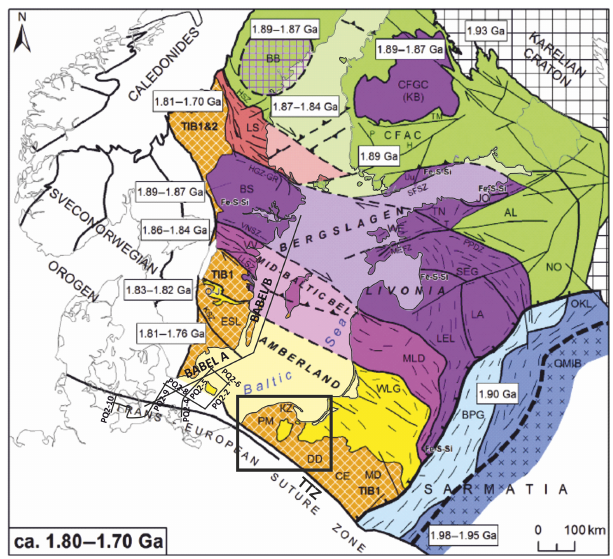
Figure 1. Major Paleoproterozoic tectonic domains of Fennoscan- dia across the Baltic Sea area. The black rectangle shows the study area. The location of the BABEL A–B (BABEL Working Group, 1993) and DEKORP-PQ (Meissner and Krawczyk, 1999) deep re- flection profiles is also marked. The known extent of the domain af- fected by the Svecofennian orogeny (coloured terranes) is bounded by the Teisseyre–Tornquist Zone (TTZ) in the SW and the Belarus– Podlasie granulite belt (BPG) in the SE. Modified from Bogdanova et al. (2015).